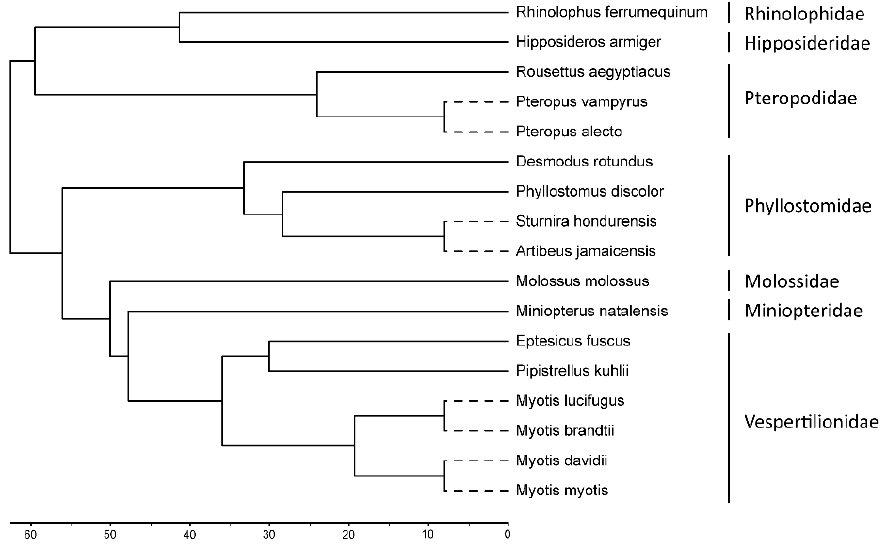
Figure 1. Phylogeny of the bat species included in this study. An ultrametric cladogram was generated using the iTOL tool [47], displaying updated phylogeny relations [35] of relevant members of the Chiroptera order. The length of branches represented by a dashed line is arbitrary and not proportional to the time scale. Table 1. Number of gene copies of TRIM6 , TRIM34 , TRIM5 , and TRIM22 found in different Chirop- tera species.